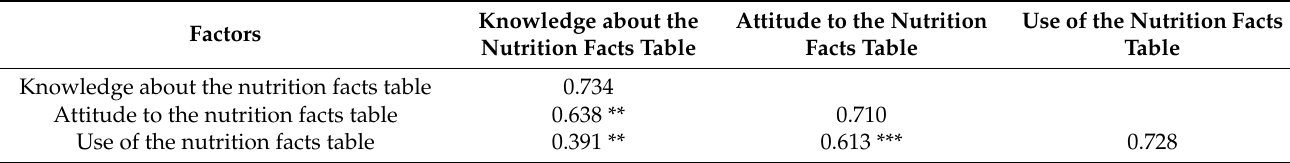
Table 4. Factor correlations and discriminant